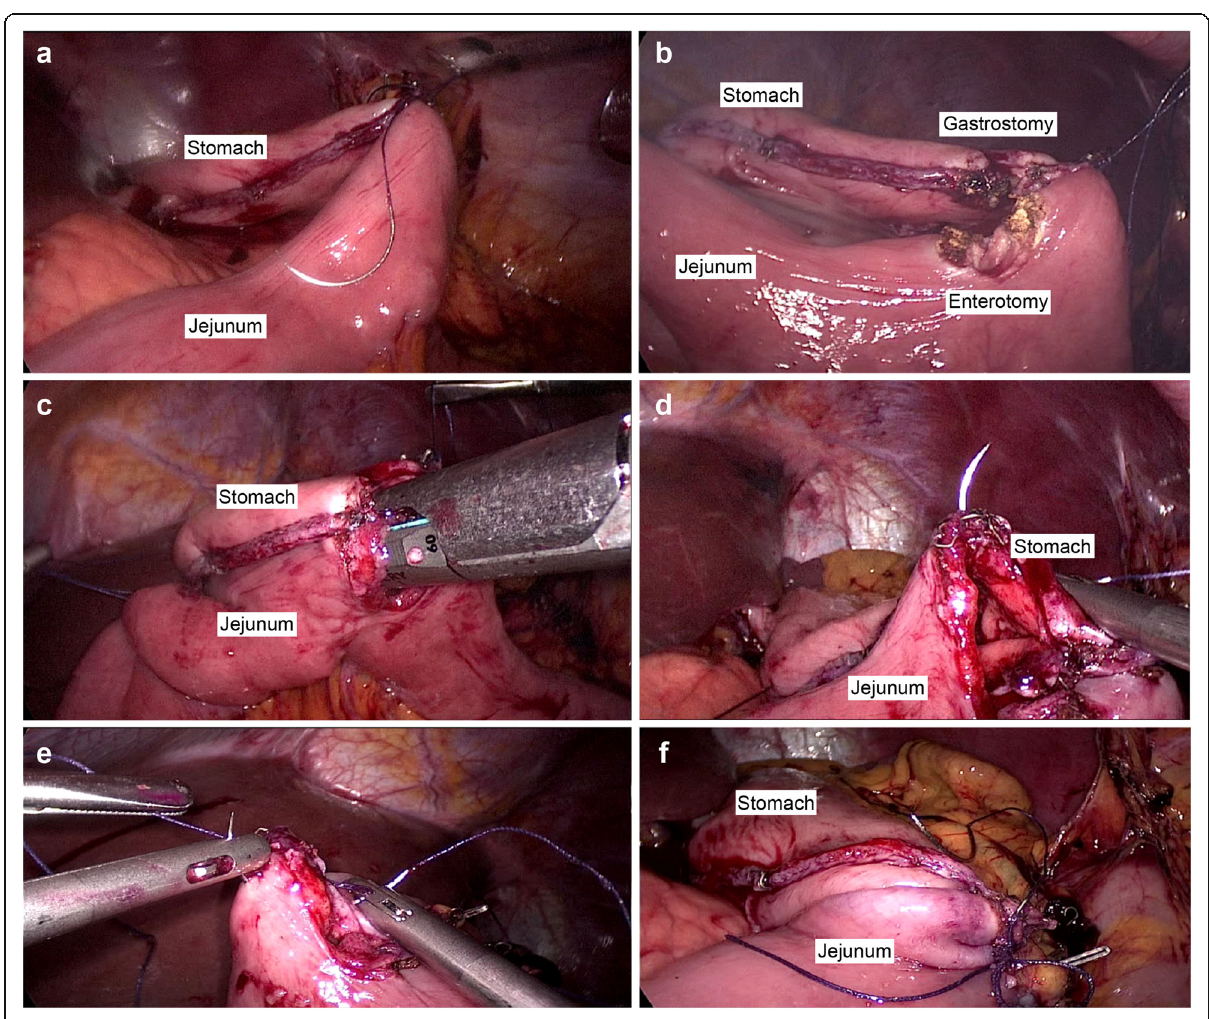
Fig. 4 Billroth II gastrojejunal anastomosis. a The proximal jejunum was approximated to the proximal gastric pouch with a traction suture. b Enterotomies in the jejunum and stomach. c Stapler was inserted through enterotomies in the jejunum and stomach. d , e , f The stapler defect was closed in two